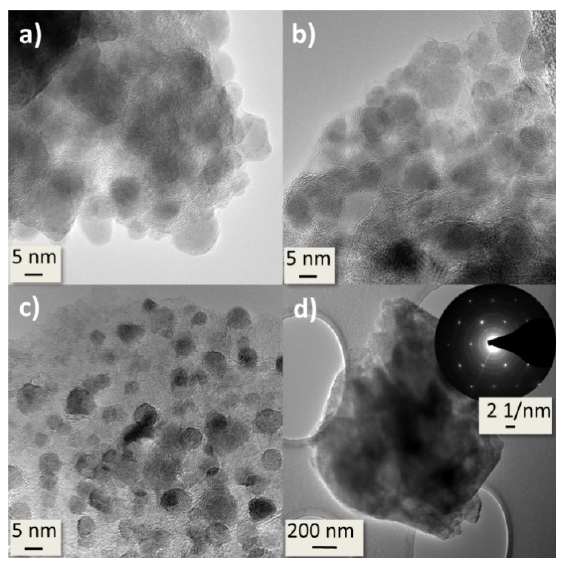
Figure 6: TEM and SAED pictures of a) C(FeF 2 ) 0.5 _300, b) C(FeF 2 ) 0.35 _300, c) C(FeF 2 ) 0.25 _300 and d) one complete particle with SAED pattern of C(FeF 2 ) 0.25